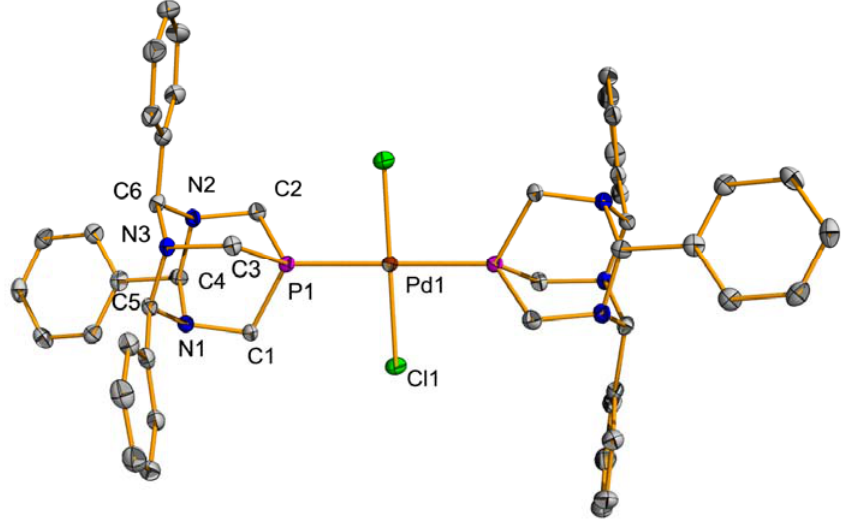
Figure 4. Thermal ellipsoid plot (50% probability) of 3 . Hydrogen atoms have been omitted for clarity. Selected bond lengths (Å) and angles (deg.): Pd1-Cl1 = 2.2930(7),